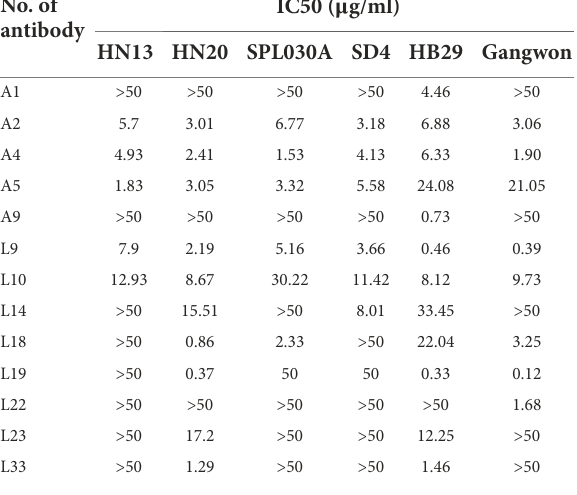
TABLE 2 Thirteen of 25 nAbs neutralized pseudovirus of HB29, Gangwon, HN13, HN20, SPL030A, and SD4 strains. No. of